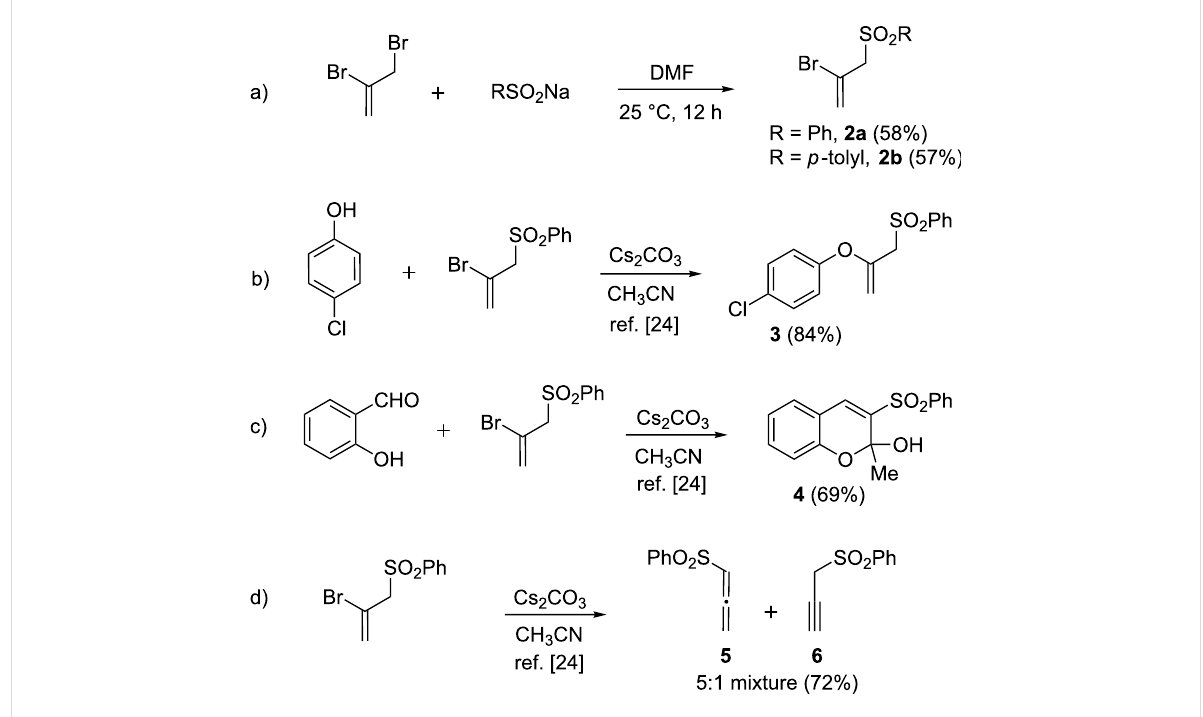
Scheme 1: a) Preparation of 2-bromoallyl sulfones 2a , b ; b) reaction of 2a with 4-chlorophenol and Cs 2 CO 3 ; c) reaction of 2a with salicylaldehyde and